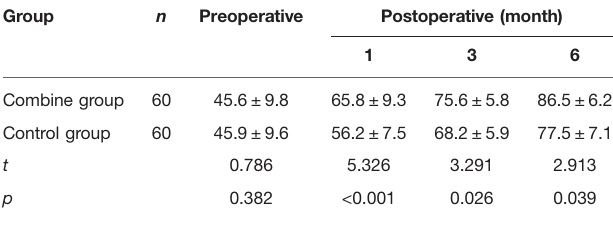
TABLE 3 | Comparison of the HSS score at different times in patients of two groups ( n , (cid:1) x + s, scores). Group